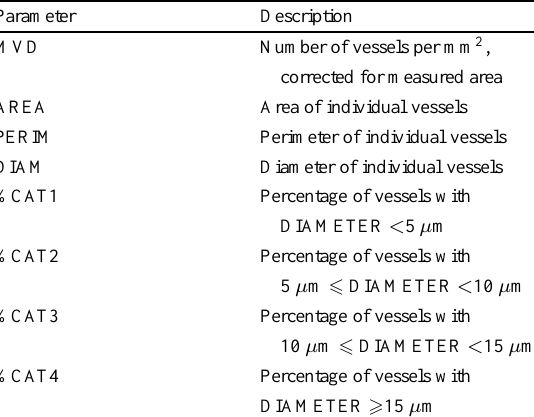
Vessel parameters and their definitions used in this study